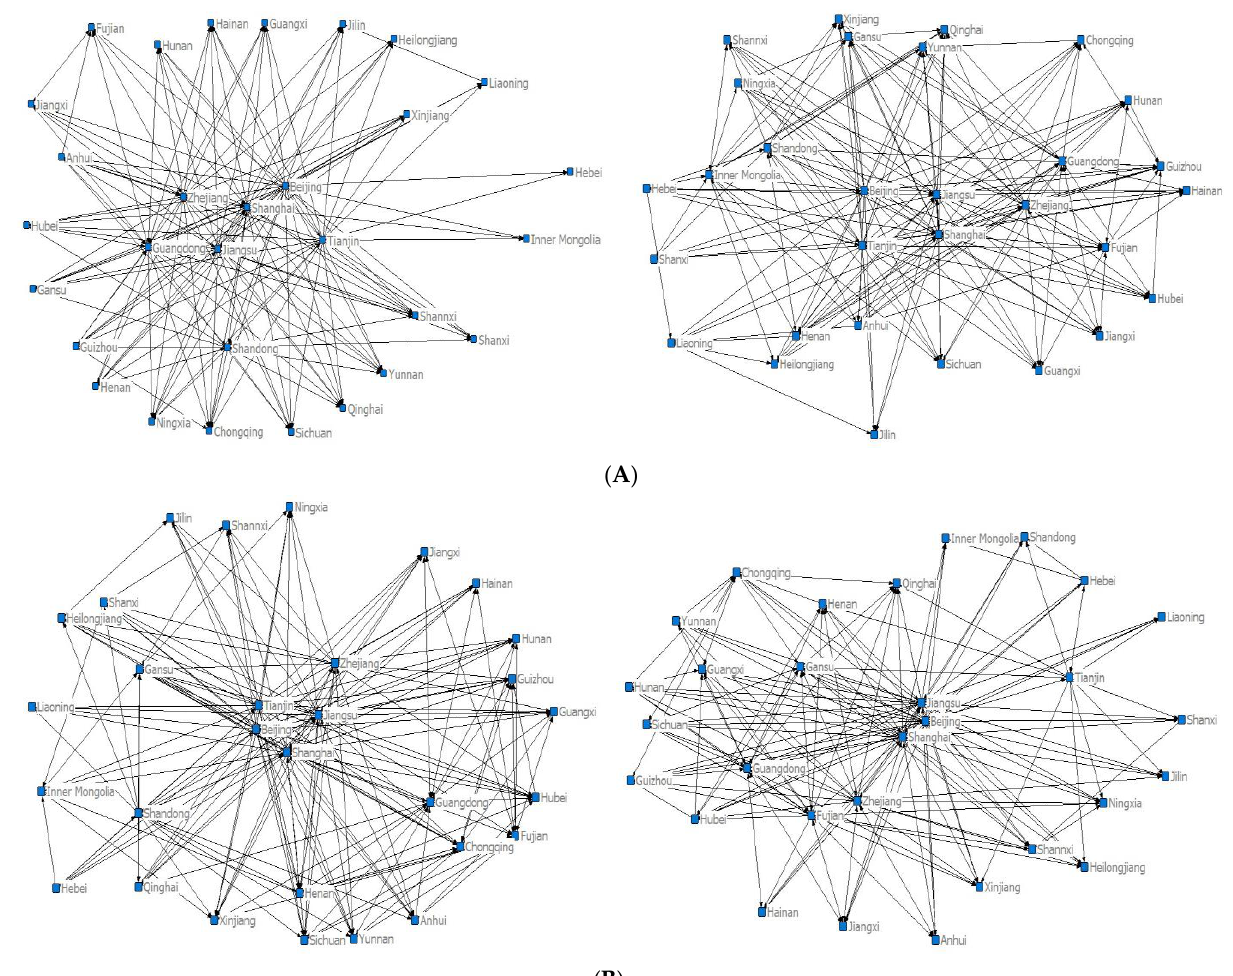
Figure 4. Spatial correlation network of China’s provincial IGGE, 2006–2020. ( A ) Spatial correlation network in 2006 and spatial correlation network in 2011. ( B ) Spatial correlation network in 2016 and spatial correlation network in 2020.